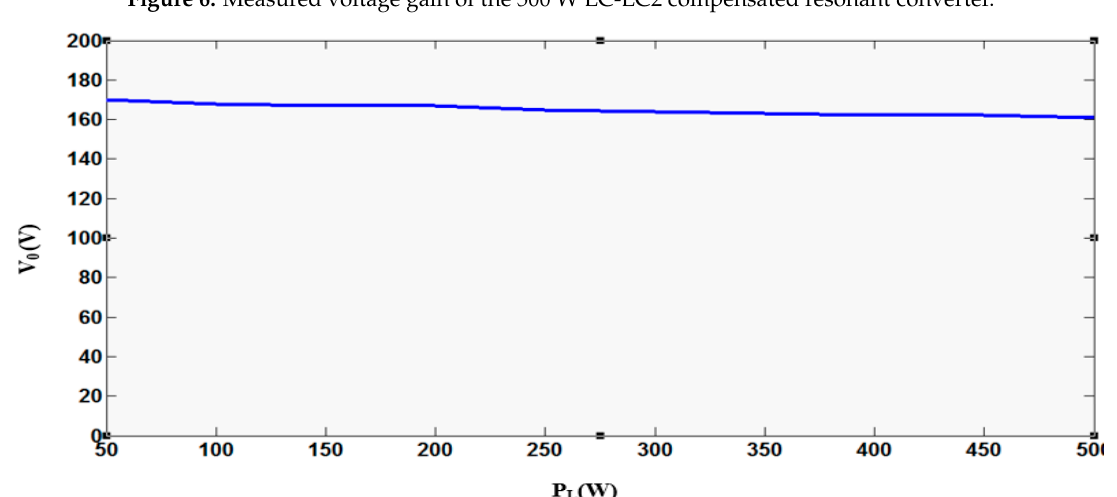
Figure 7. Measured load regulation of the 500 W LC-LC2 compensated resonant converter.